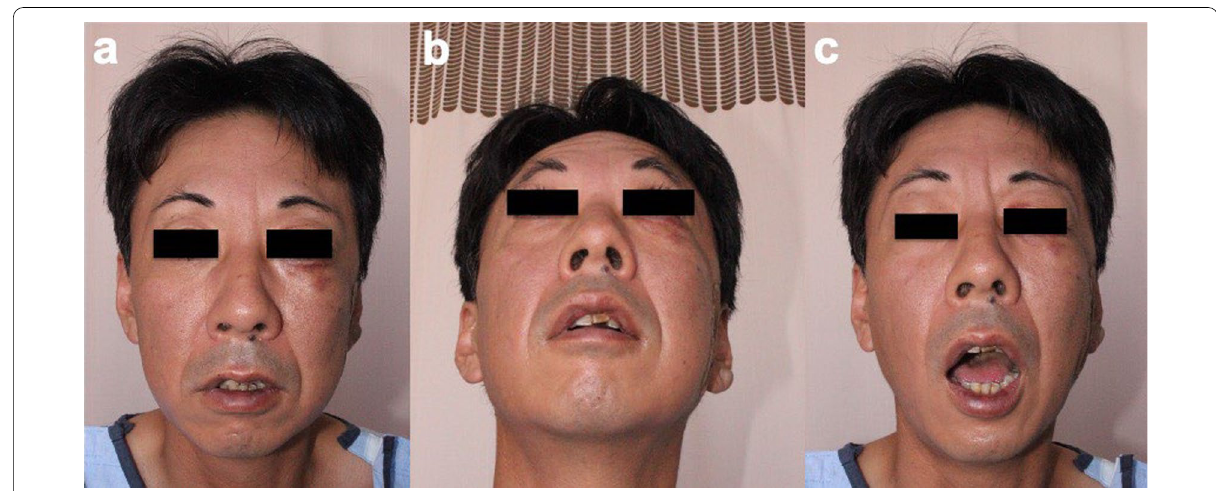
Fig. 1 a He felt hypesthesia in the area of malocclusion of the second branch of the trigeminal nerve. b His left cheek was more deviated downward than the right cheek. c He had difficulty opening his